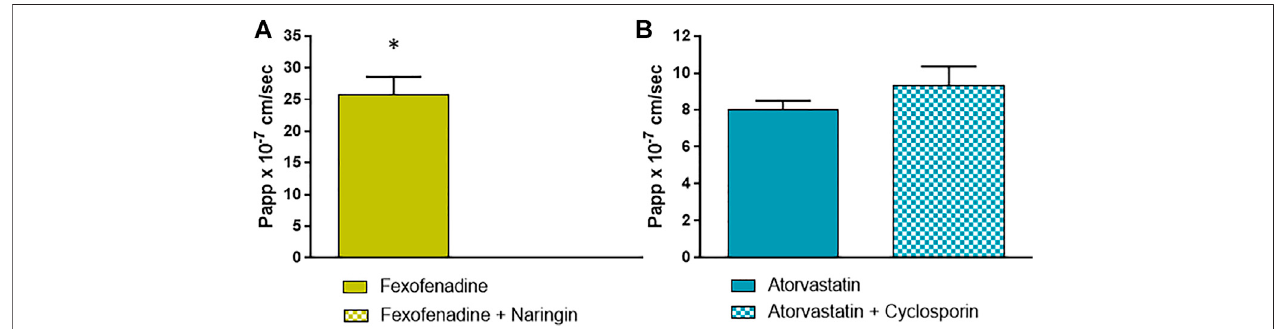
FIGURE 4 | Papp values of (A) fexofenadine with and without naringin as probe substrate and inhibitor of OATP 1A2; and (B) atorvastatin with and without cyclosporin as probe substrate and inhibitor of OATP 2B1. Details are given in M&M. Results are expressed as means ± standard deviations. Stars represent statistical signi fi cance of the results with p < 0.05.